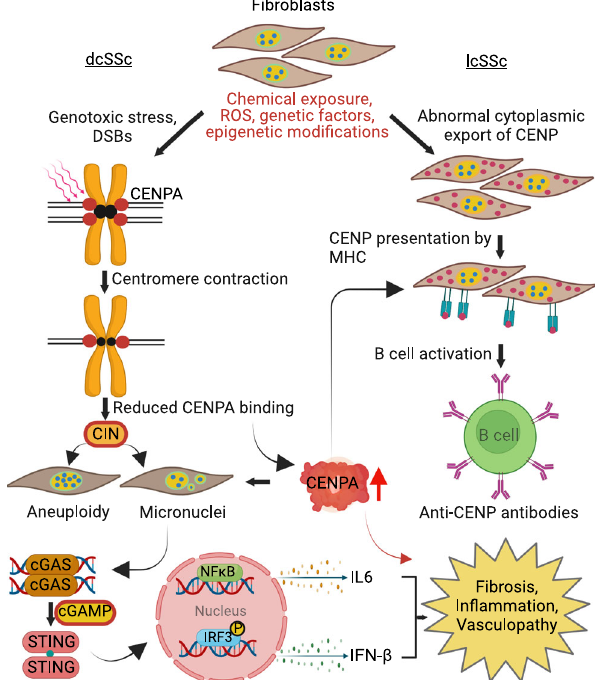
Fig. 9 | The model depicting how centromere alterations and chromosome instability could impact the etiology of Systemic Sclerosis. The damage to skin fi broblasts leads to centromere DNA alterations and/or abnormal centromere protein deposition in the cytoplasm. In dcSSc, centromere damage produces centromeric contractions and reduction of CENPA deposition at the centromere, leading to unstable kinetochore and microtubule attachment. These processes result in chromosome instability (CIN), characterized by aneuploidy and micro- nuclei formation and upregulation of CENPA. The overexpression of and/or mis- localization of CENPA alters gene expression as we have seen in cancer 45 . In lcSSc, altered deposition of CENP proteins leads to CIN characterized by micronuclei formation as well as to excess of CENPA deposition. In lcSSc patients who develop ACAs,centromereDNAissomewhataffectedandcentromereproteinsleakintothe cytoplasm, further increasing the level of CENPA expression, which further drives CIN characterized by micronuclei formation. Given that fi broblasts from patients with SSc are known to express MHC on their surface, these MHC molecules likely present the cytoplasmic CENPs to B cells to induce production of ACAs. The pre- senceof extranuclearDNA(micronuclei)inallSSc fi broblastsleadsto activationof the cGAS-STING/IFN- β pathway and autoimmunity. DSBs doubled-strand breaks, IFN- β interferon beta, IL6 interleukin 6, CENP centromere protein, MHC major histocompatibility